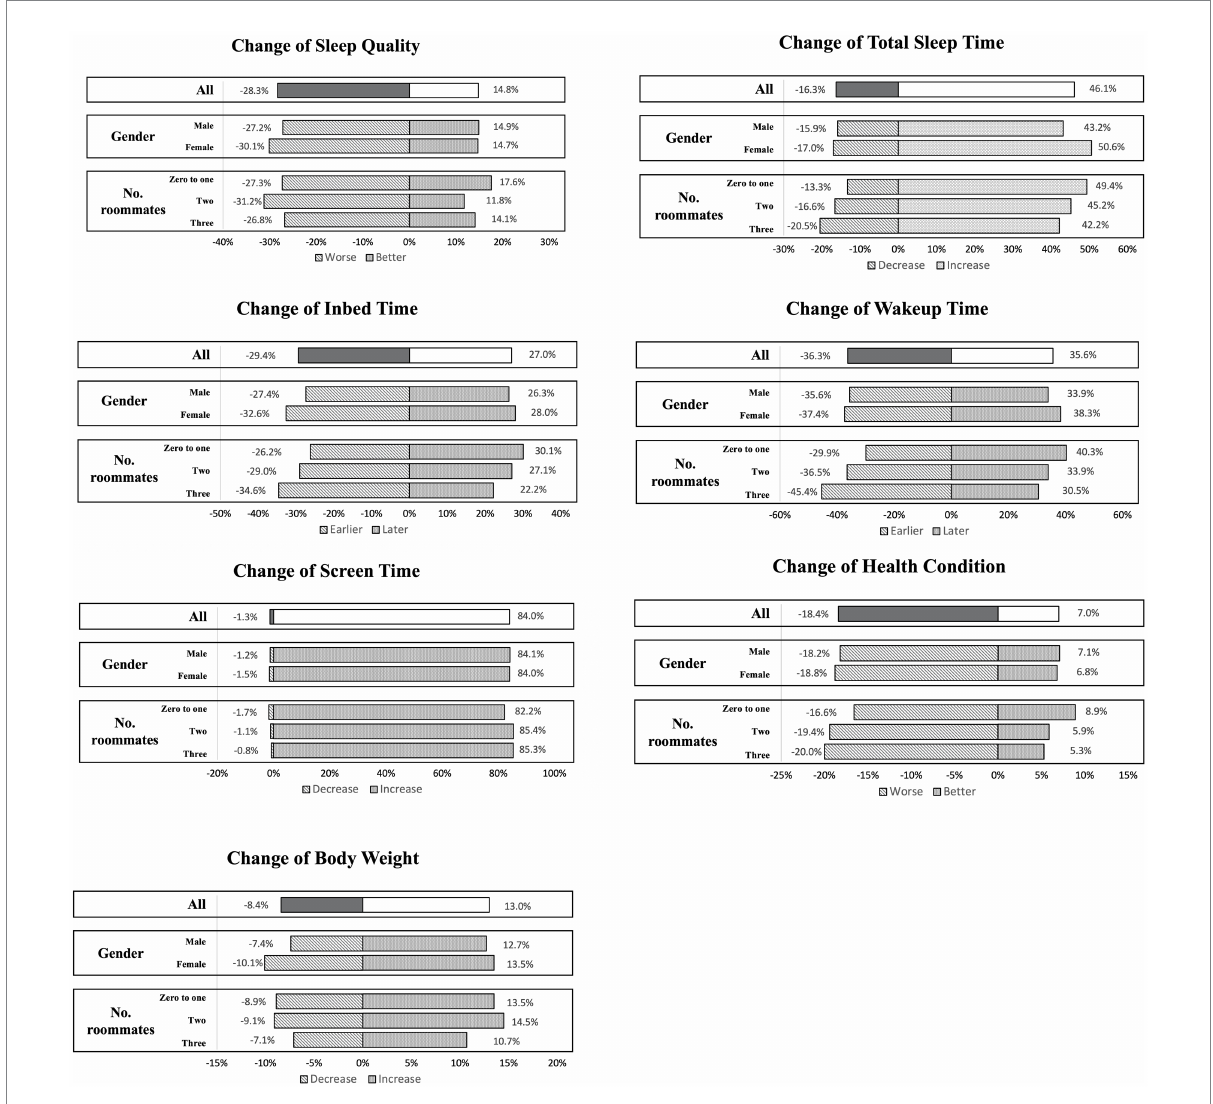
FIGURE 3 Changes in health behavior and condition among different gender and living